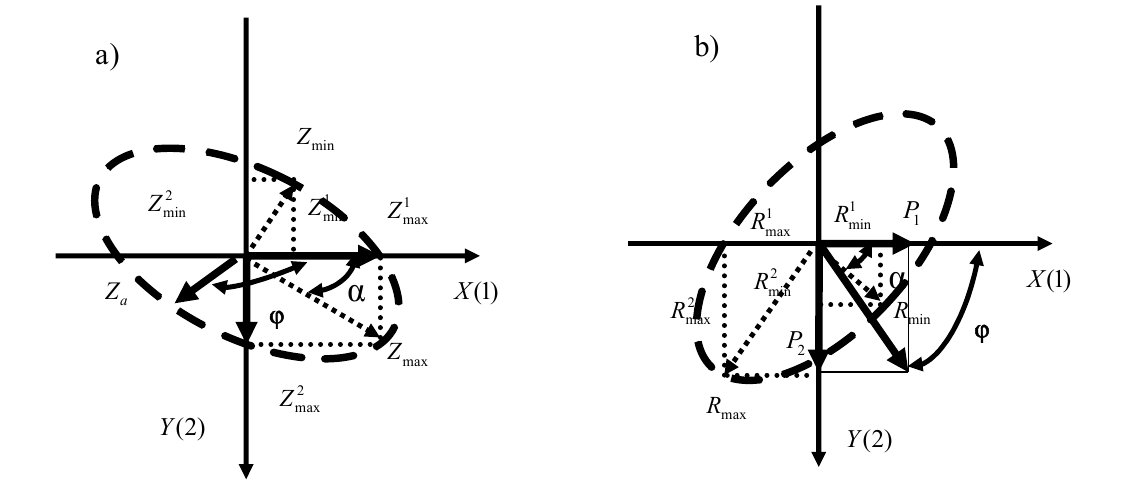
Figure 4. The ellipse of the external flexibility of the system ( a ) and the ellipse of the external rigidity of the system ( b ) for the first state of self-tension.